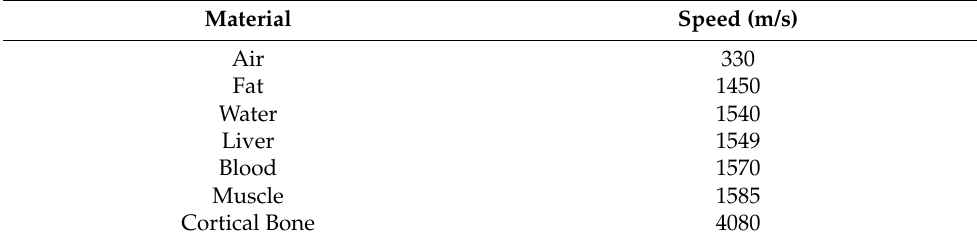
Table 1. Transmission rate of ultrasound waves depending on the medium. Material Speed (m/s)